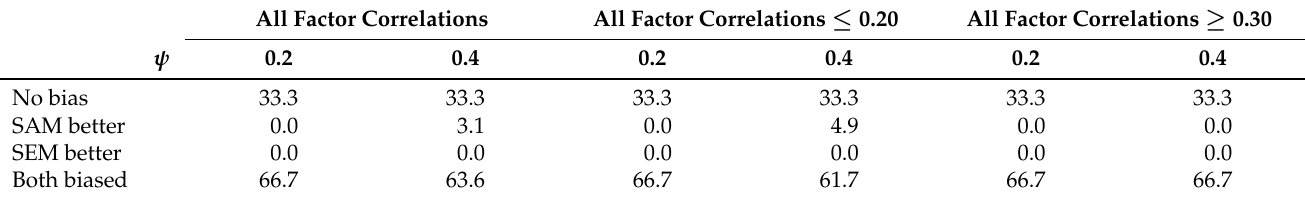
Table 11. Simulation Study 6 (three factors and residual correlations): percentages of factor correlation estimates in data constellations in which SAM and SEM are unbiased (“no bias”), SAM is